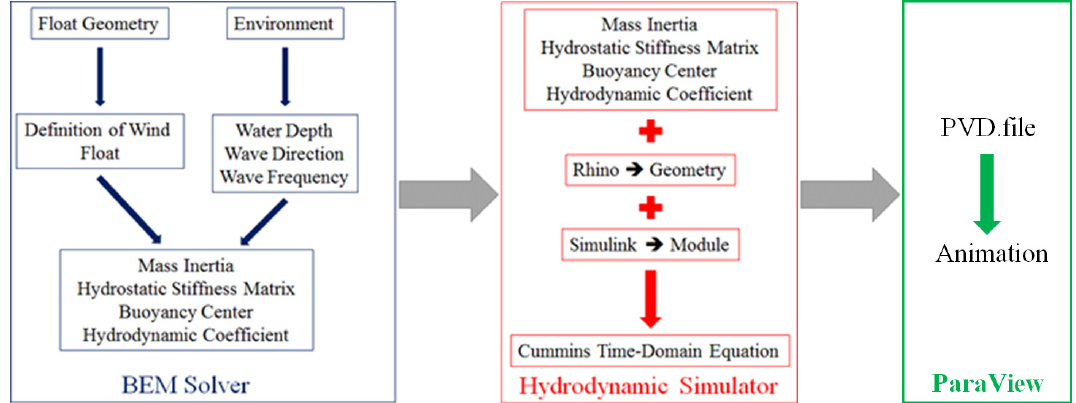
Figure 4. A flowchart of the modular system.